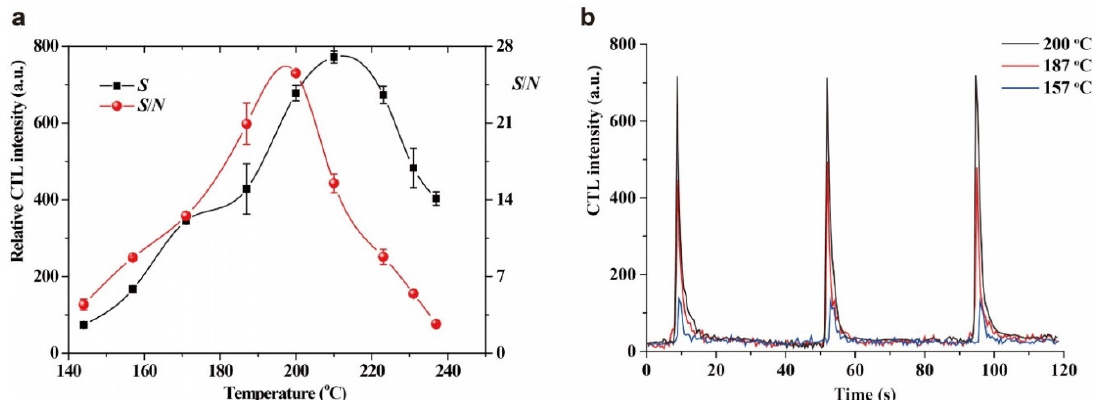
Figure 4. ( a ) E ff ect of temperature on the relative CTL intensity and the S / N . Test conditions were: air flow rate: 80 mL / min. wavelength: 425 nm, concentration:, 1.2 mg / L. ( b ) The CTL response profiles of acetaldehyde at working temperatures of 157 ◦ C, 187 ◦ C and 200 ◦ C. Test conditions were: air flow rate: 80 mL / min, wavelength: 425 nm, concentration: 1.2 mg / L. Error bars stand for ±